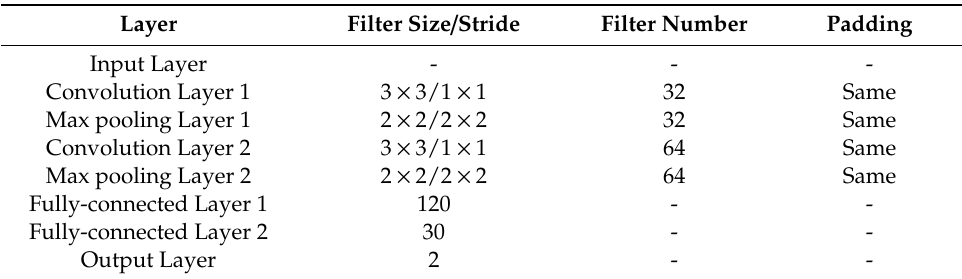
Table A1. Details of each individual CNN classifier.